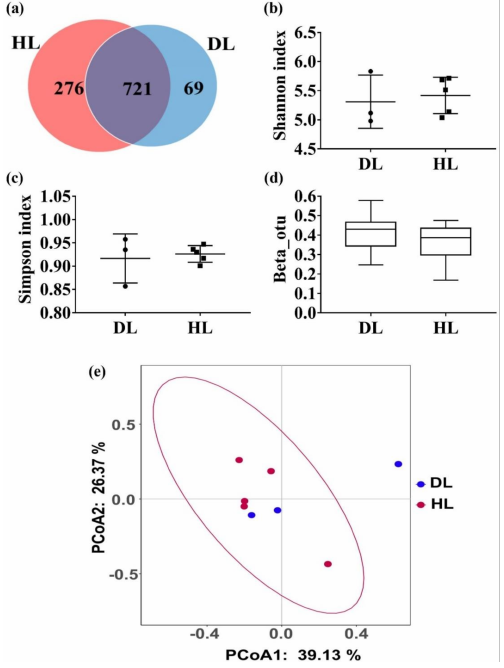
Figure 4. Fecal microbiota characteristics in three kids with diarrhea (DL) and five healthy kids (HL) after Bacillus amyl-liquefaciens-9 administration collected at day 15. Bacterial 16S rRNA genes were amplified and sequenced. ( a ) OUT Venn Diagram, ( b ) Alpha diversity (Shannon index), ( c ) Alpha diversity (Simpson index), ( d ) Beta diversity, and ( e ) PCoA (PCoA1 = 39.13%, PCoA2 = 26.37%) of the HL and DL kids. Values are mean ± SEM. * p < 0.05 was considered statistically significant. At the phylum level, no significant difference was observed in all predominant micro- biota (Supplementary Materials, Figure S4). The predominant bacterial group (Table 2) at the genus level (relative abundance > 1%) except Erysipelotrichaceae_UCG-003 also showed no significant change (Supplementary Materials, Table